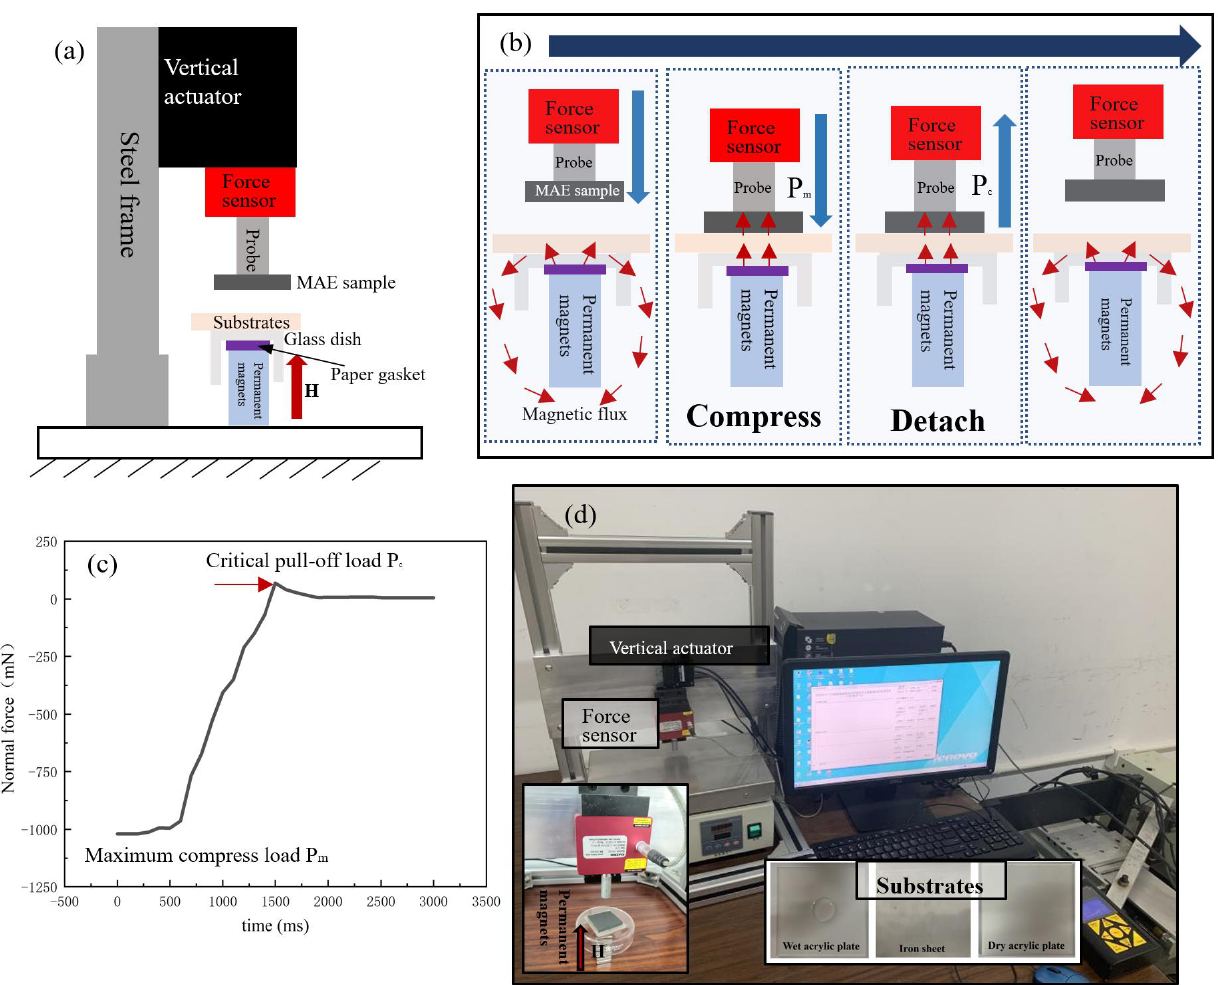
Figure 3. The contact adhesion tester ( a ) The schematic diagram ( b ) The testing process ( c ) The normal force vs. time curve ( d ) The picture of the contact adhesion tester.